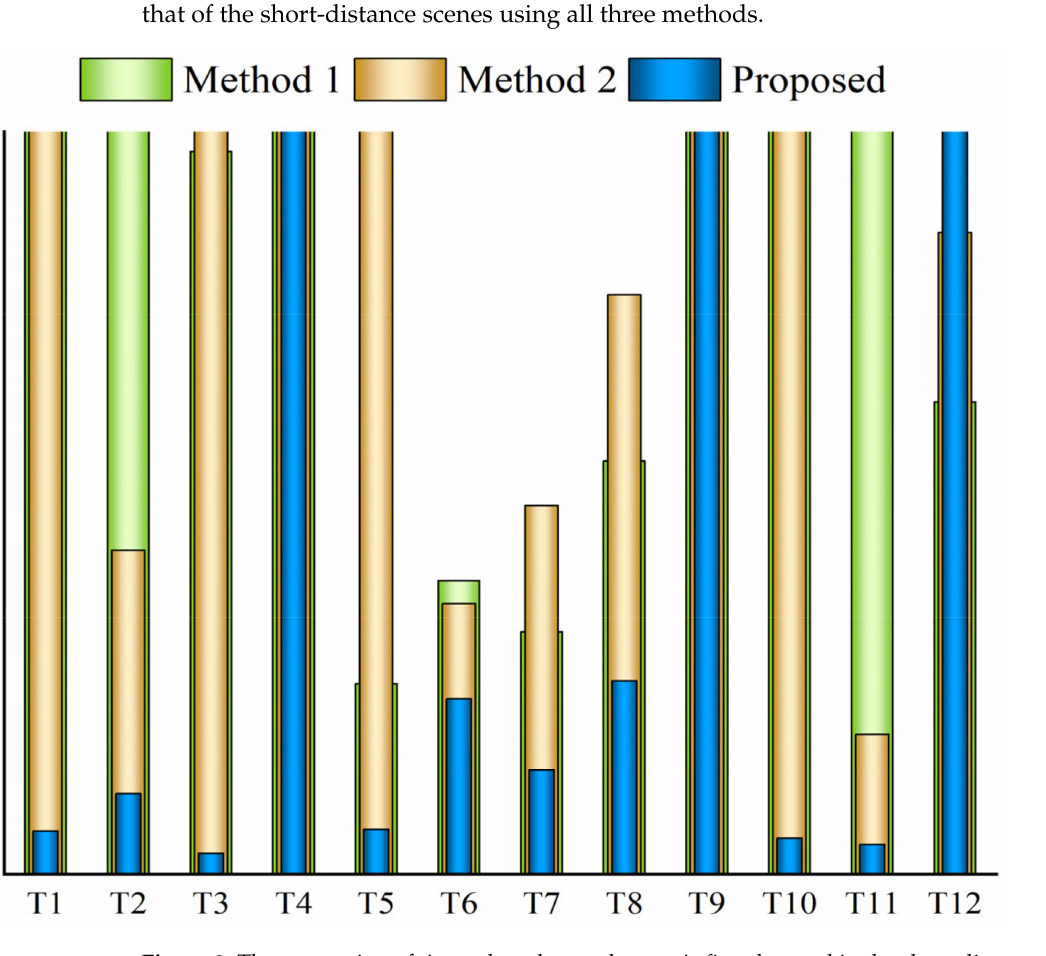
Figure 8. The proportion of time when the smoke root is first detected in the short-distance